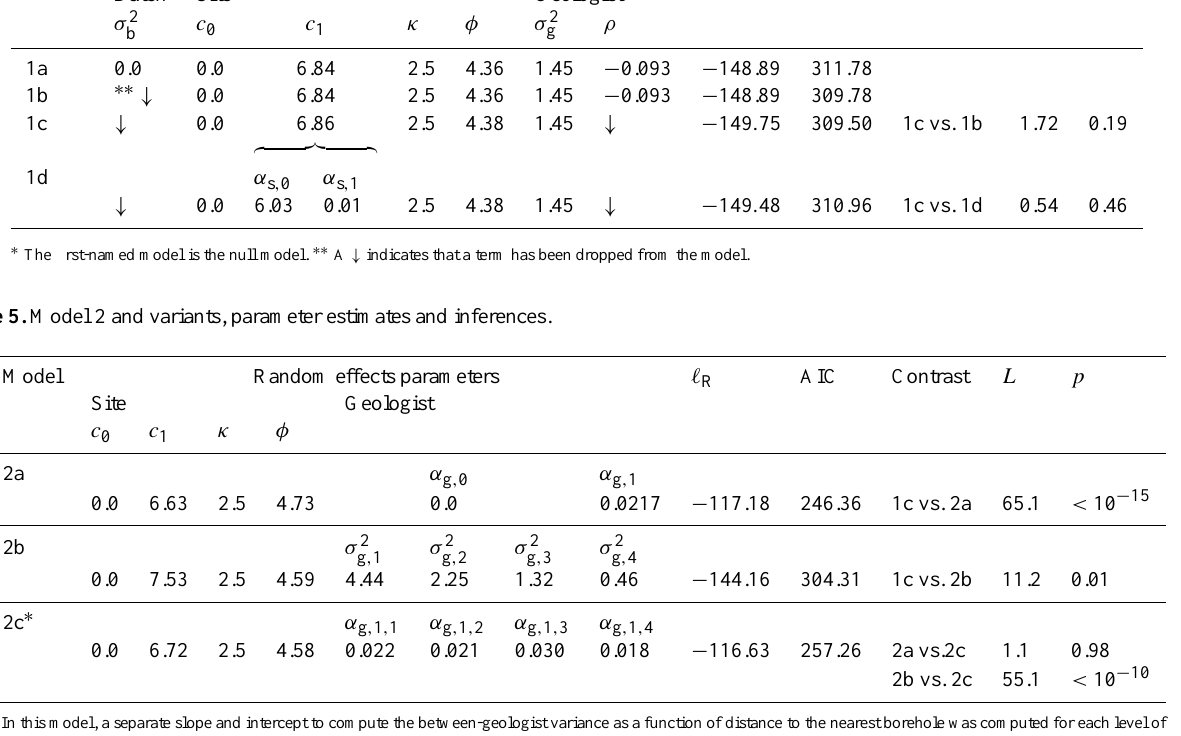
Table 4. Model 1 and variants, parameter estimates and inferences. Model